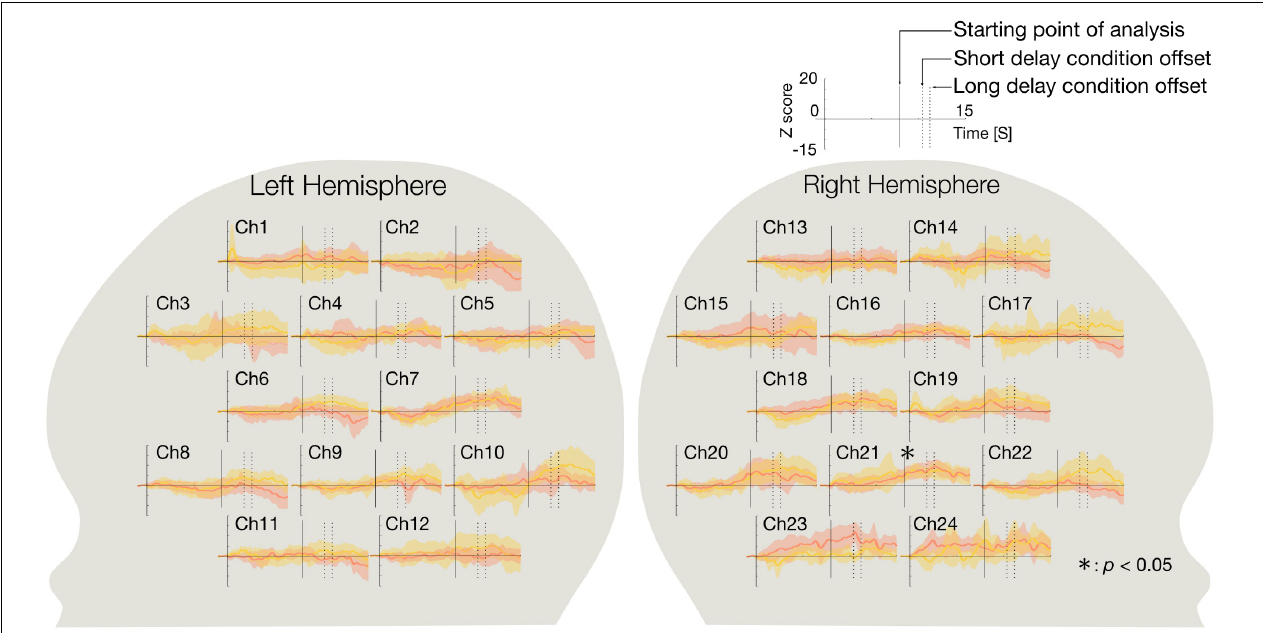
FIGURE 2 | The time course of the average Z-score of oxy-Hb during the short and long delay conditions. The graphs on the left side show the time course of the average Z-score of the concentration of oxy-Hb changes in each channel in the left hemisphere, and those on the right side show the time course of the average Z-score of the concentration of oxy-Hb changes in each channel in the right hemisphere. The red line represents the time course of the average Z-score of the short delay condition and the yellow line represents the time course of the average Z-score of the long delay condition. Shaded regions of red and yellow indicate 95% confidence intervals. On the horizontal axis, 0 represents the onset of the presentation of the stimulus. Intersections of the horizontal axis and solid line represent starting point of analysis (8.0 s), and dotted lines represent the offset of the stimulus of the short delay condition (10.4 s), and the long delay condition (11.2 s). In both conditions, the concentration of oxy-Hb at Ch 21 (right occipitotemporal region) were significantly greater relative to the baseline ( p < 0.05). Asterisk indicates the significance level of statistical differences: ∗ p < 0.05.